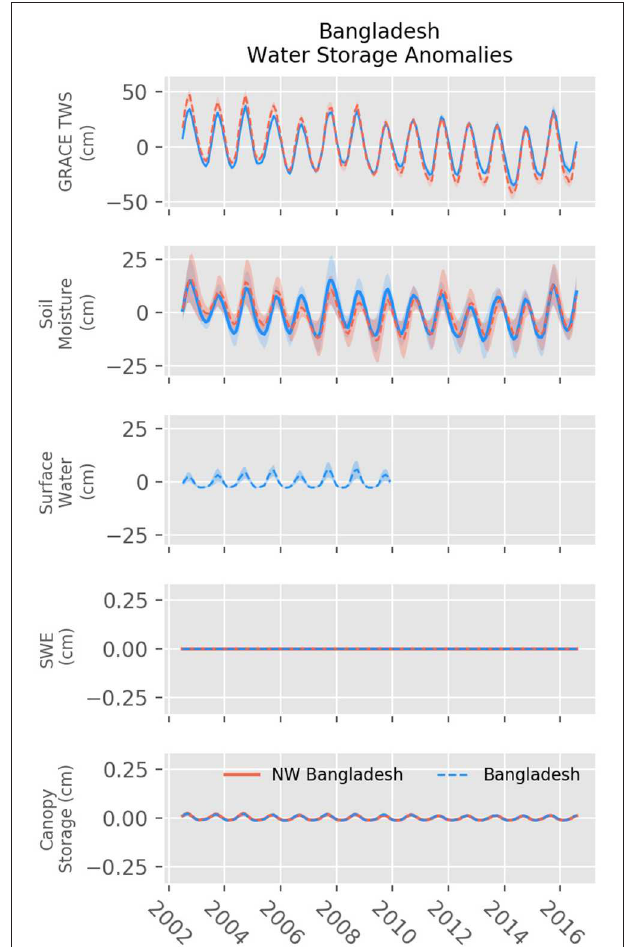
FIGURE 2 | Changes in water storage anomalies for GRACE terrestrial water storage (Top), soil moisture (2nd from Top), surface water (3rd from Top), snow water equivalent (4th from Top), and canopy water storage (Bottom). Red lines show changes in storage for Bangladesh. Blue dashed lines show changes in storage for Northwest Bangladesh. GRACE observations show a decline in storage from 2003 to